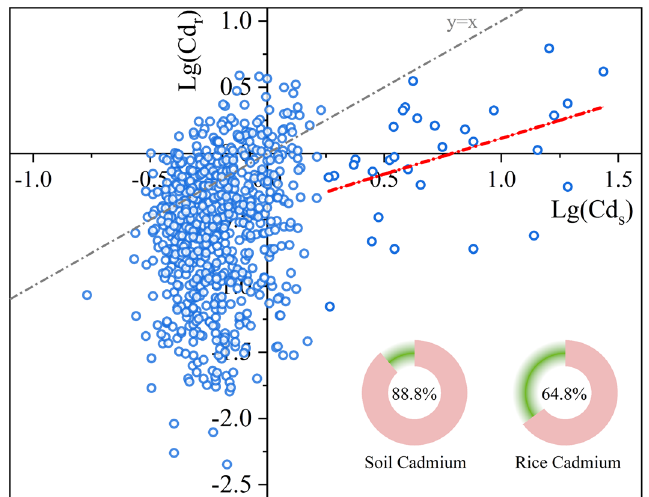
Figure 4. The cadmium contents in soil and rice in the study area. The pie chart showed the exceeding standard rates of cadmium in soil and rice,